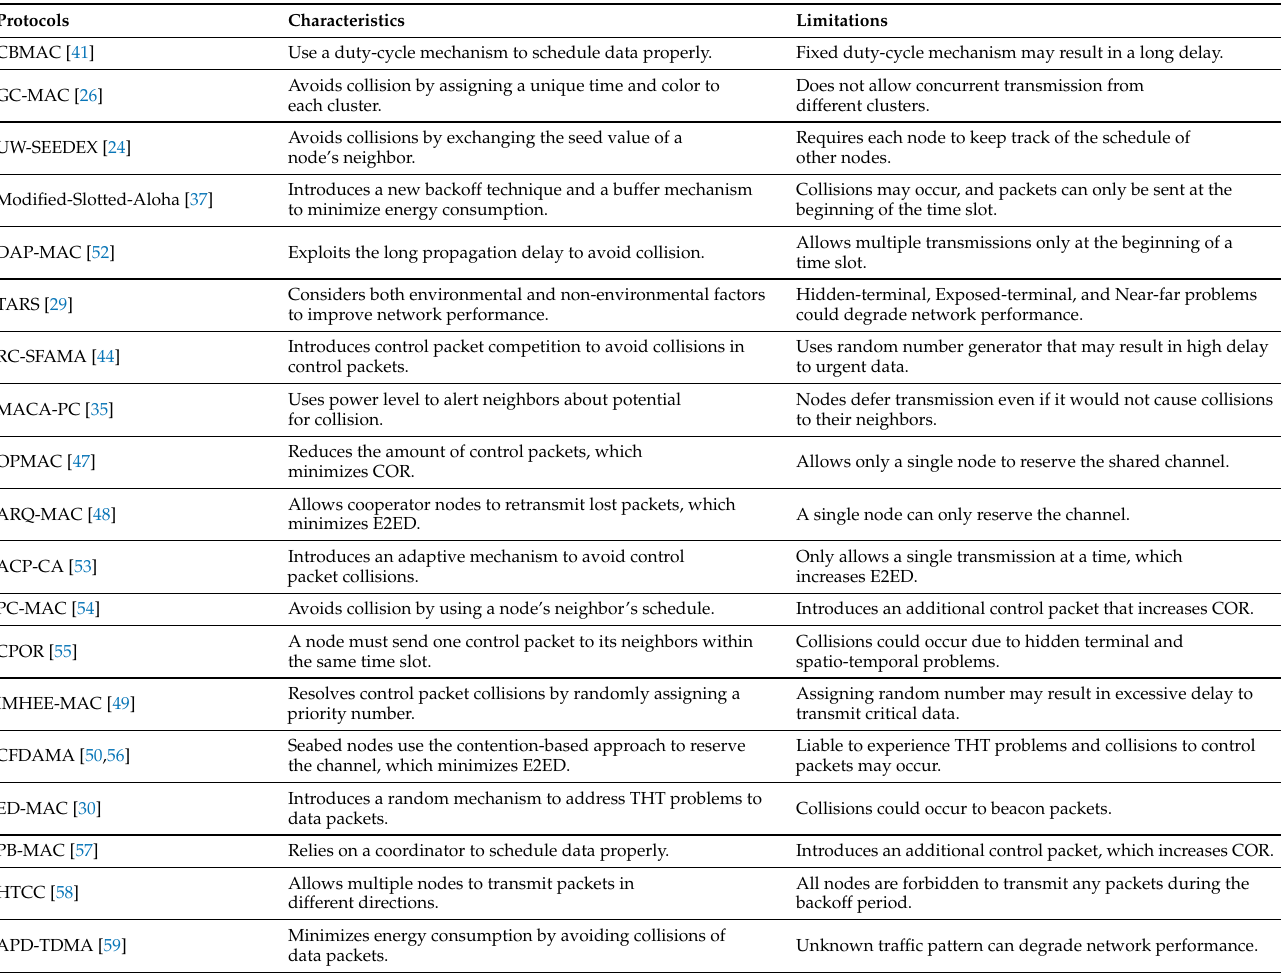
Table 3. Summary of Characteristics and Limitations of MAC